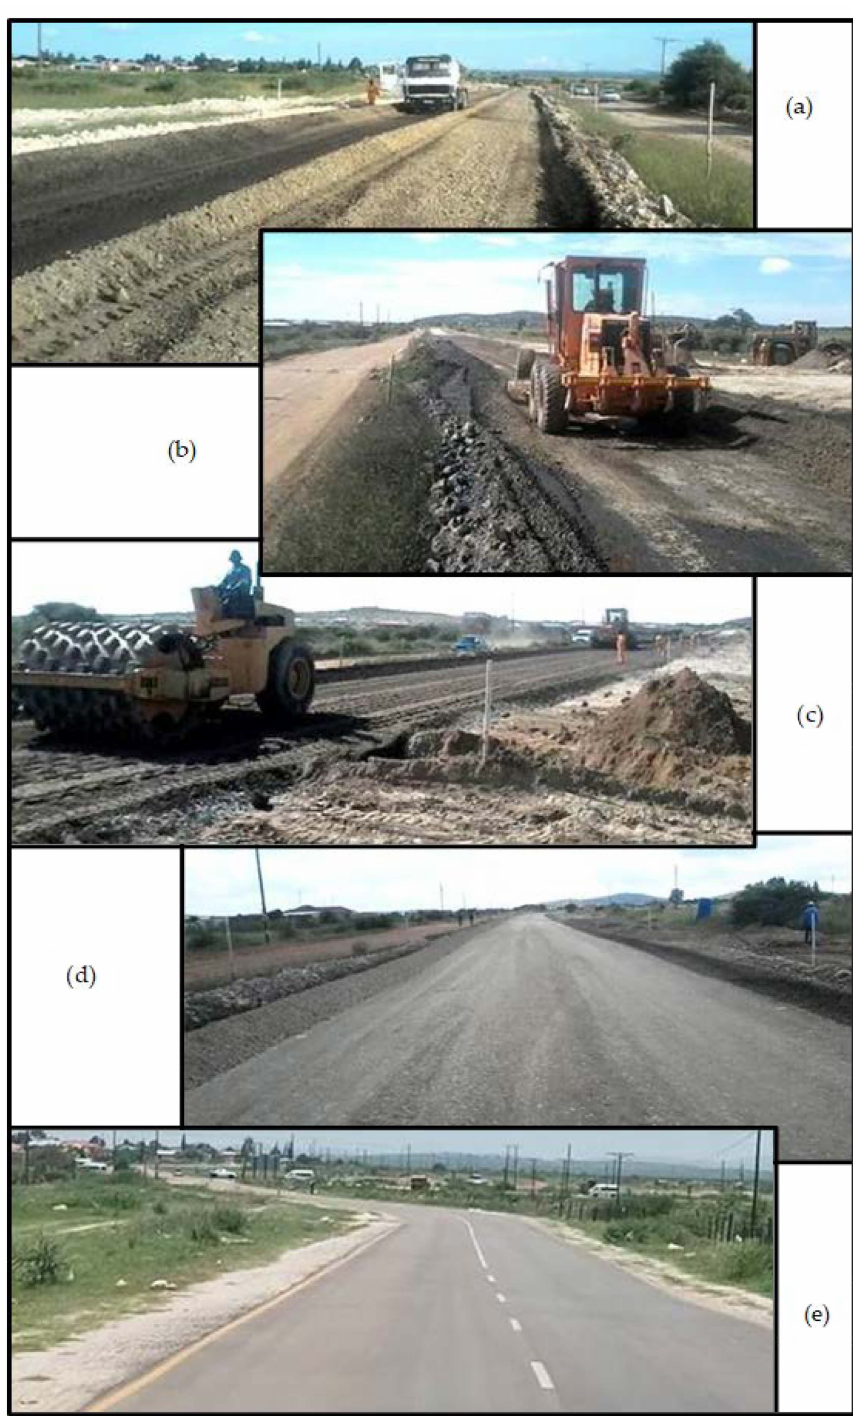
Figure 17. ( a ) Water-bowser with construction water and anionic NME stabilising agent. ( b ) Single grader used for mixing of the anionic NME stabilising agent pre-mixed within the construction water. ( c ) Compaction and cutting of final layer levels. ( d ) Condition of the compacted layer prior to applying a tack-coat and surfacing. ( e ) Condition of the surfaced road 6 years after